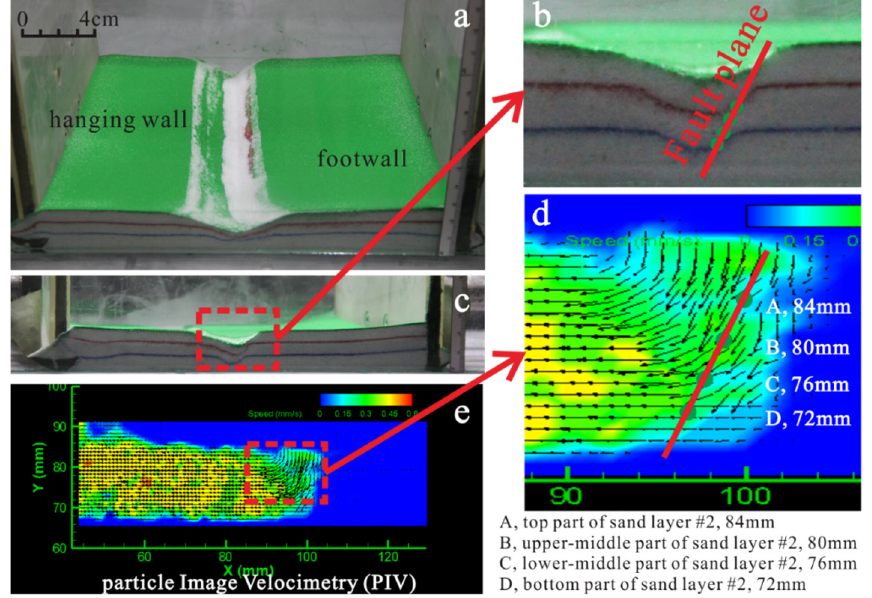
Figure 7. Experimental phenomena, including top ( a ) and front ( c ) views and partial enlargement ( b ). PIV results ( e ) and partial enlargement ( d ), as well as the four recording points, are depicted on the fault